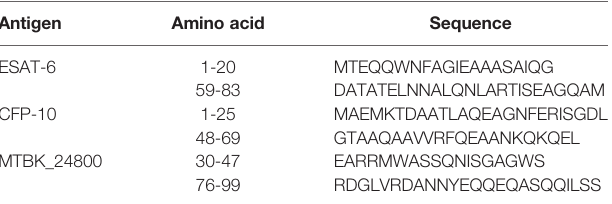
TABLE 1 | Amino acid sequences of M. tb antigens.